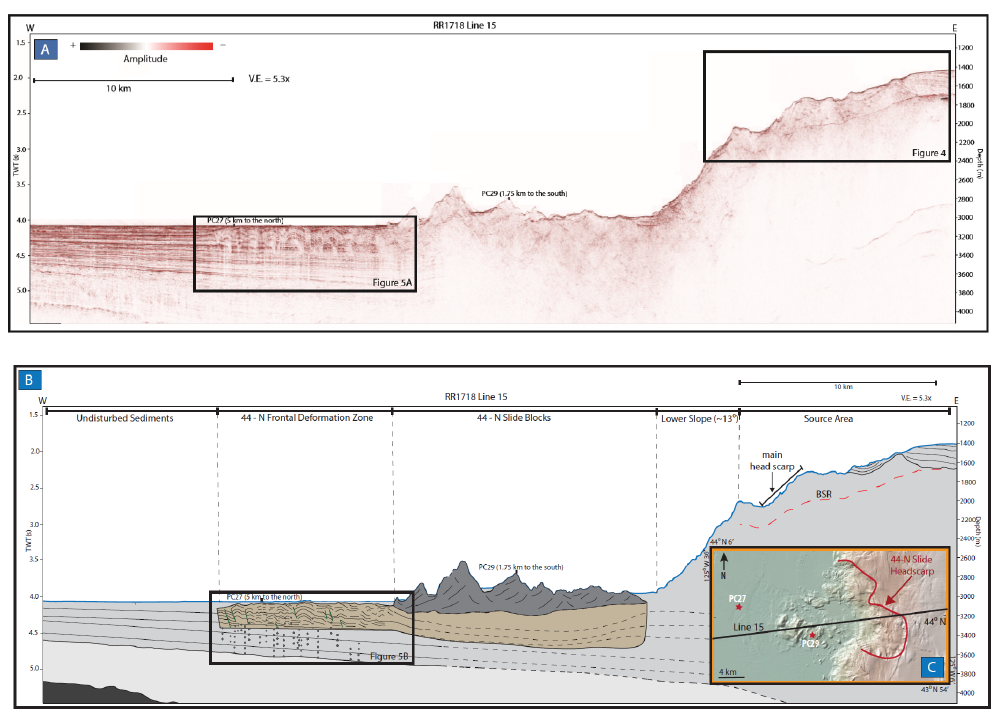
Figure 2. Plot of the vane peak undrained shear strength for the upper 100 meters below seafloor for passive margins (blue) and active margins (red) with ODP Leg 146 Site 892 overlain (black). This plot suggests the pre-failure sediment of the 44 North Slide could have had a similar profile of relatively strong shear strength. Figure modified from Sawyer and DeVore, 2015 [24].